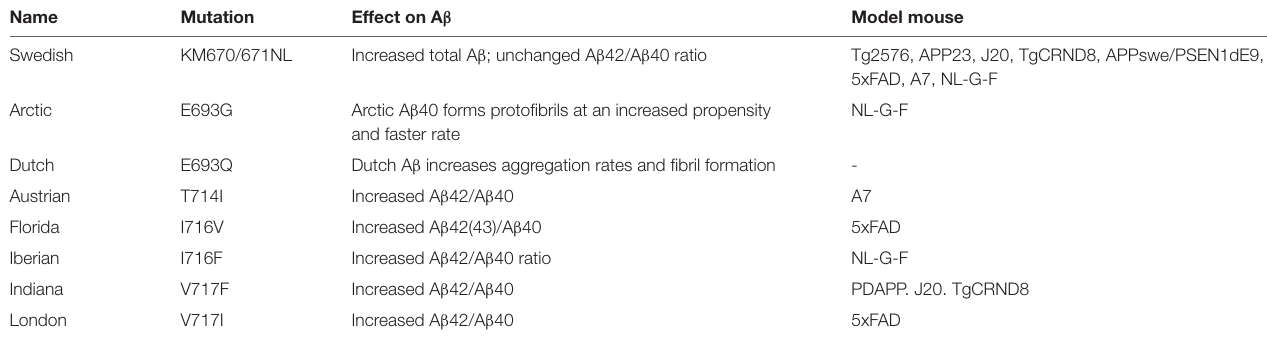
TABLE 1 | Representative FAD-linked mutations in APP gene used in model mice.